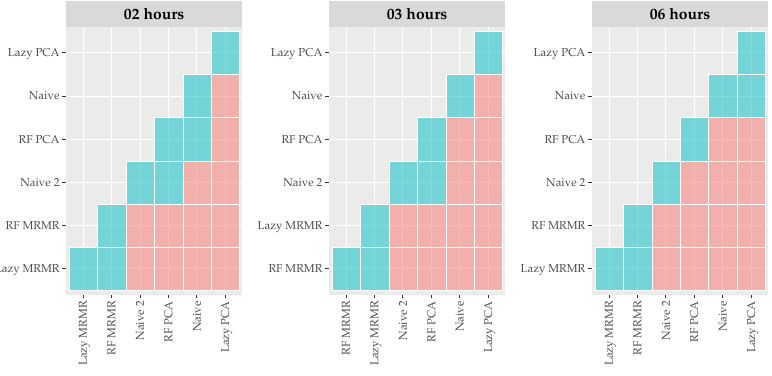
Figure 11. Visualization of a Post Hoc